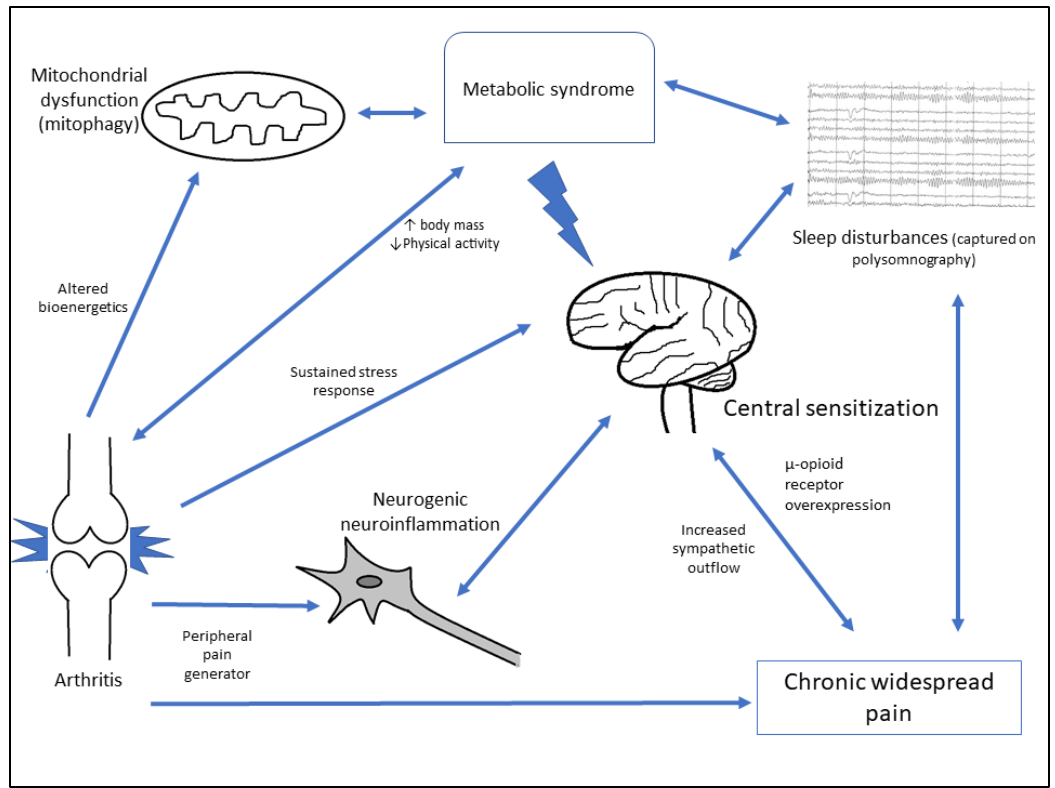
Figure 1. Flow-chart of proposed unifying